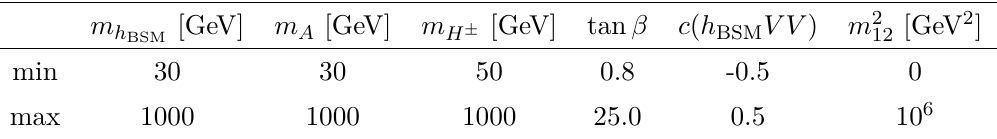
Table 2. Input parameter ranges for the parameter scan in the type I